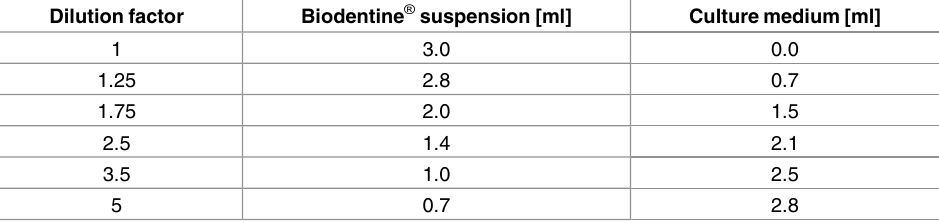
Table 2. Serial dilution of the suspensions of five Biodentine ® discs of day 1. Dilution